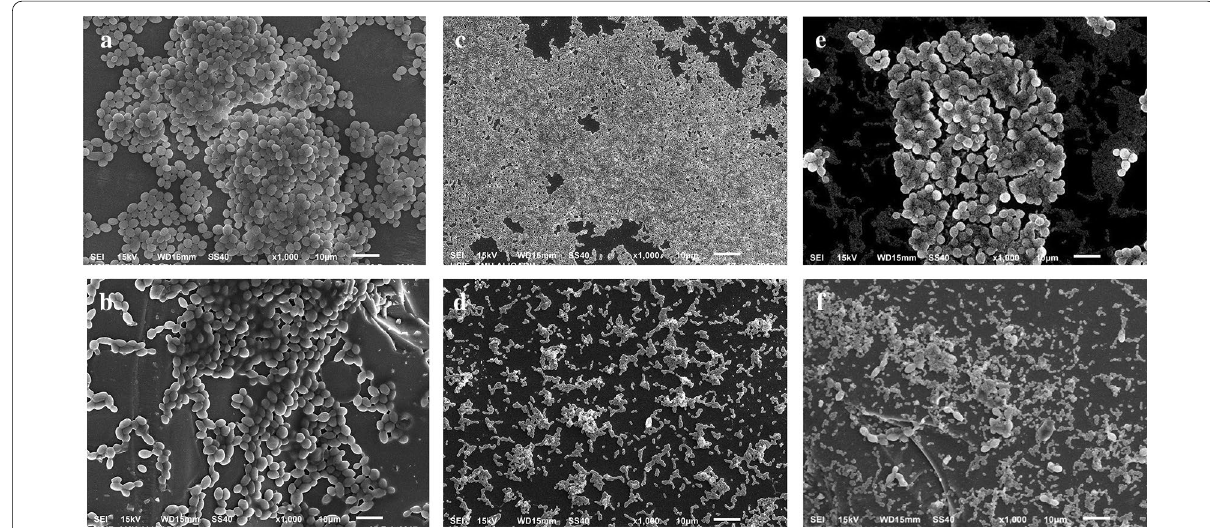
Fig. 2 Eradication of pre-formed C. albicans (CAJ-01) and S. mutans MTCC497 single and mixed biofilms by the treatment of eugenol. a CAJ-01 untreated biofilms, b Treated with eugenol at 400 µg/mL, c S. mutans MTCC497 untreated biofilm cells, d S. mutans MTCC497 biofilm cells treated with eugenol at 400 µg/mL, e Untreated CAJ-01 and S. mutans MTCC497 mixed biofilm cells (Jafri et al. 2019), f . CAJ-01 and S. mutans